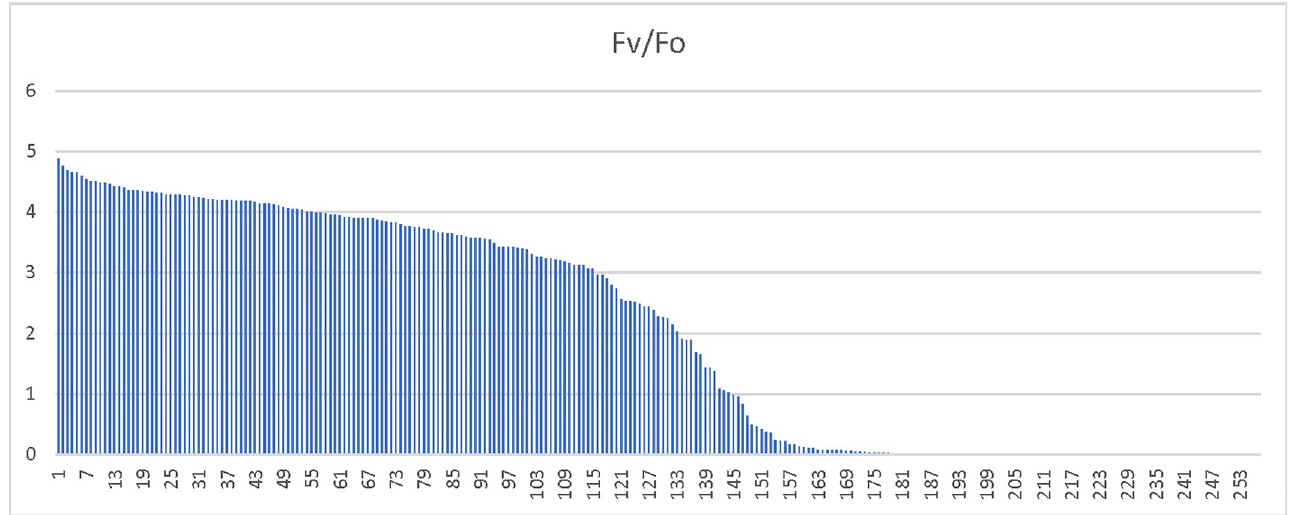
Fig 4. Chlorophyll fluorescence values from RIL families after low temperature stress. Chlorophyll fluorescence measures (Fv/Fo) for an individual from each of 254 F2:F5 RIL families two week following low temperature treatments described in the methods section. The Y axis represents the Fv/Fo values which are indicative of physiological